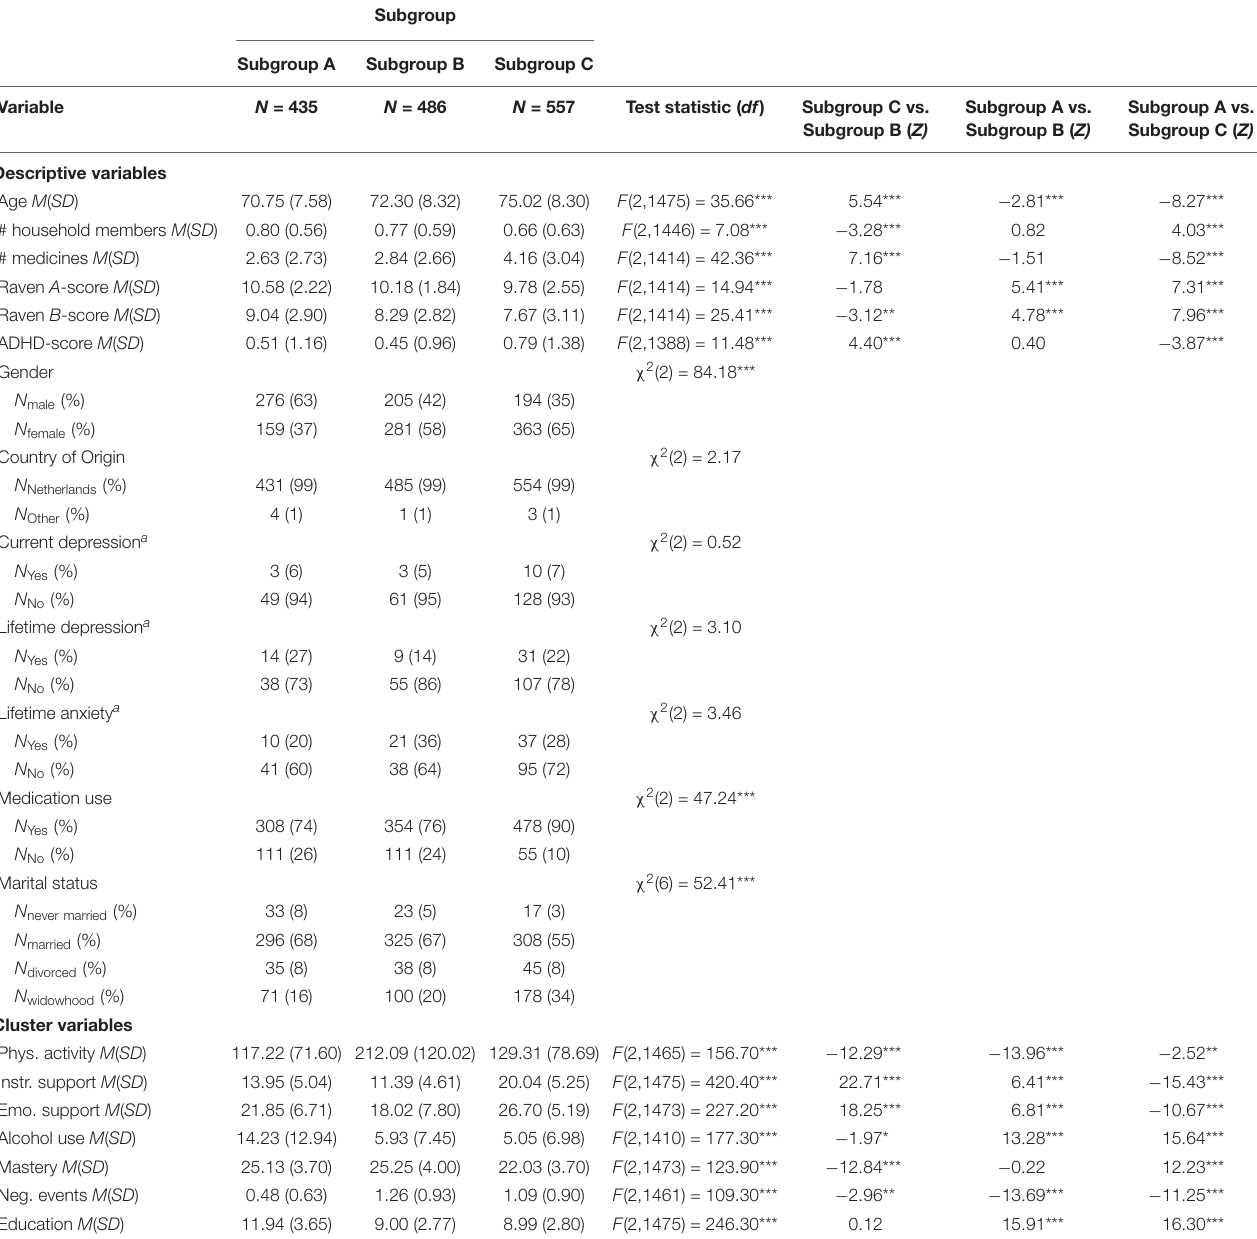
TABLE 1 | Raw cluster variable scores and descriptives for each of the three community detection-based subgroups formed on T1 data ( N = 1478).